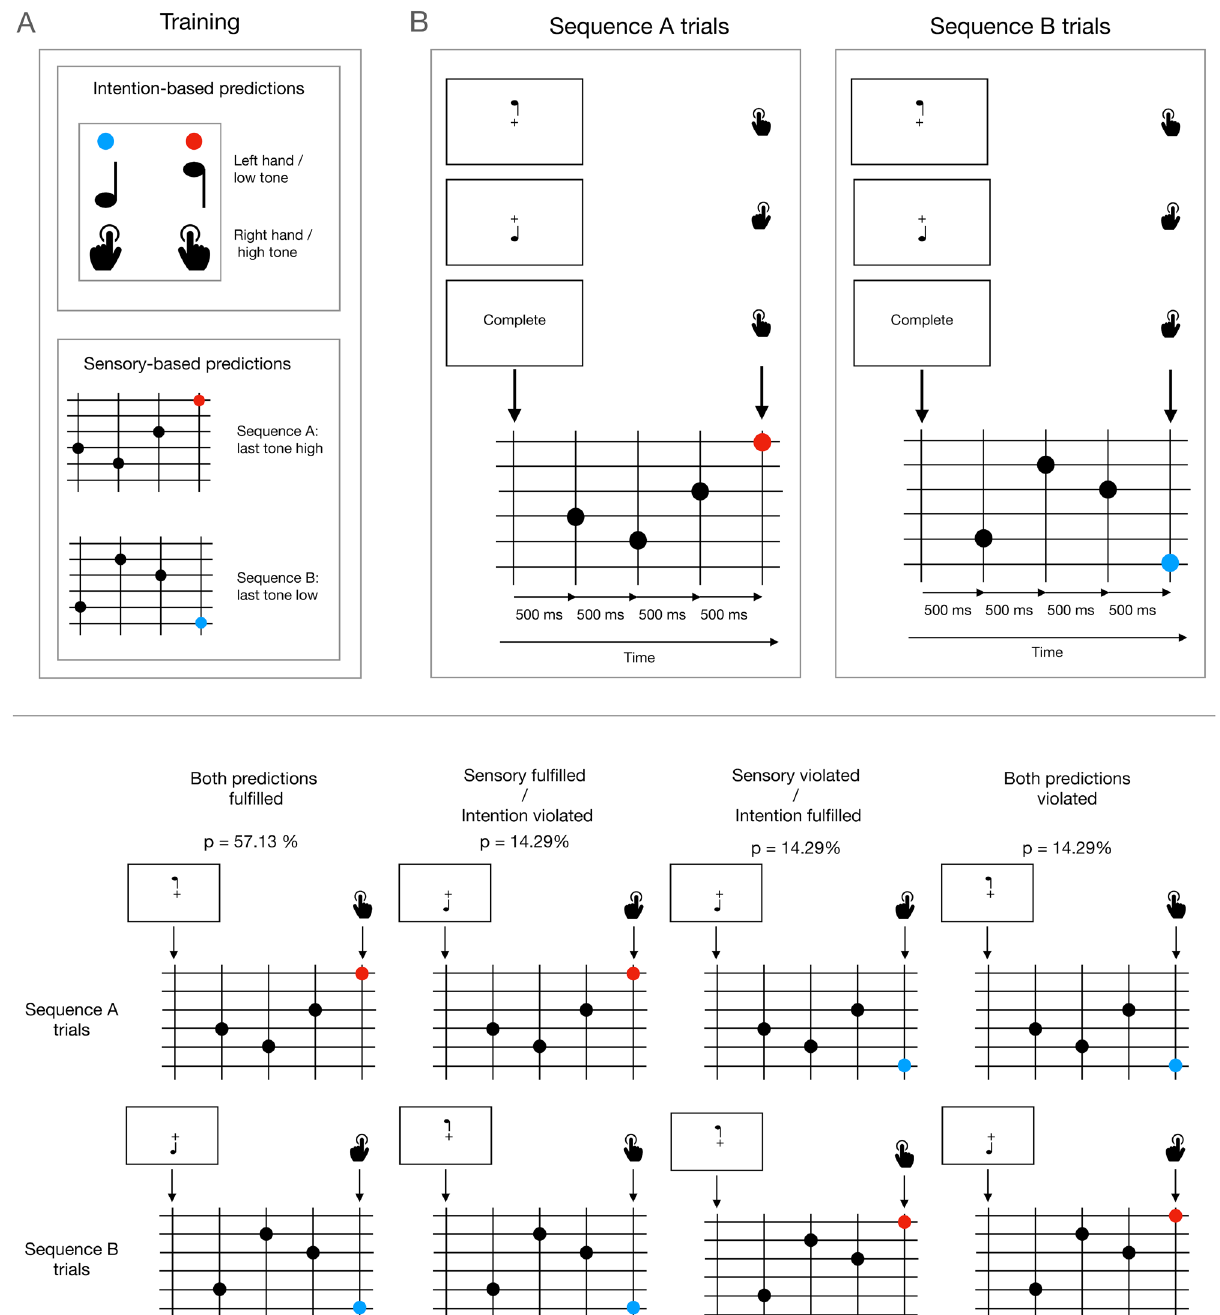
Figure 1. Upper panel Schematic description of the task. ( A ) Prior to the experiment, participants performed a series of training blocks aimed at allowing them to associate left and right keypresses with high and low tones (intention-based predictions) and to learn the two possible sequences they could be presented with (sequence A, sequence B), each ending either with the same high or low tones (sensory-based predictions) participants associated with each of the keypresses. Participants performed four blocks of 20 trials for each type of prediction. Additional, shorter training (one block of 10 trials for each type of prediction) was provided before each experimental block. ( B ) On each experimental trial, participants were presented with either sequence A or B, randomly intermingled between trials. Every trial commenced with a cue signal (500 ms), prompting participants to press a key in order to produce the last tone of the sequence in synchrony with the moment in which it should be played. This cue indicated participants to press either the key that produces the high tone, the key that produces the low tone, or the key that produces the tone that completes the sequence (catch trials). Therefore, the last tone could be predicted on the basis of the preceding sequence of tones (sensory-based predictions) and on the basis of the executed action (intention-based predictions), yielding four experimental conditions: sensory and intention predictions fulfilled (57.13% of trials), neither sensory nor intention predictions fulfilled (14.29%), sensory fulfilled but intention prediction violated (14.29%), and sensory violated but intention prediction fulfilled (14.29%). Lower panel Representation of the four possible experimental conditions for trials from two given sequences A and B, as indicated in the upper panel, together with the relative probabilities of each condition over the total number of